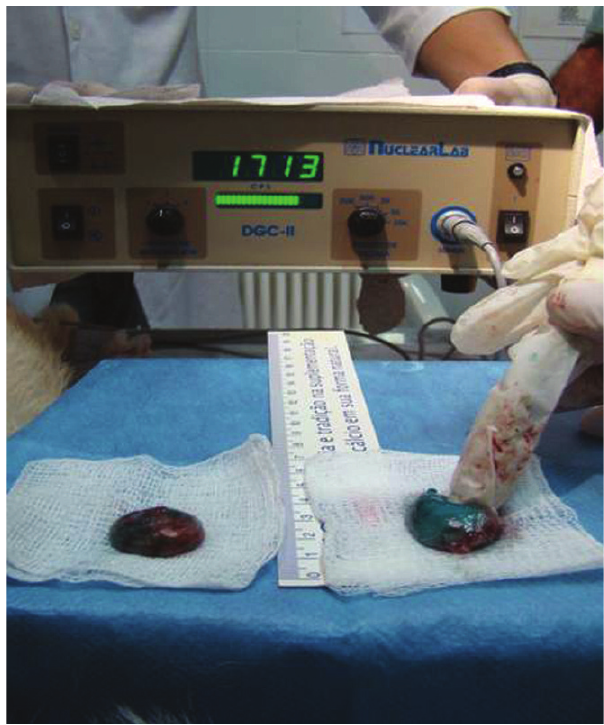
Figure 5 - Measurement the radiocolloid uptake ex vivo after the removal of the